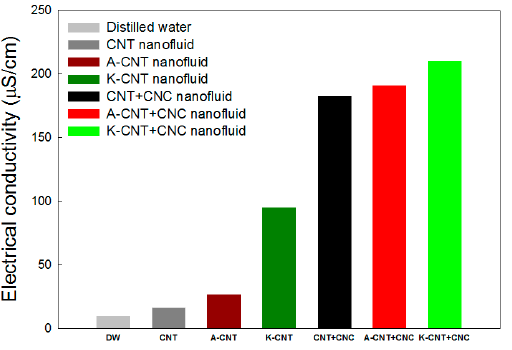
Figure 6. Electrical conductivity of pristine MWCNTs, surface modified MWCNTs, and surface modified MWCNTs with CNC.